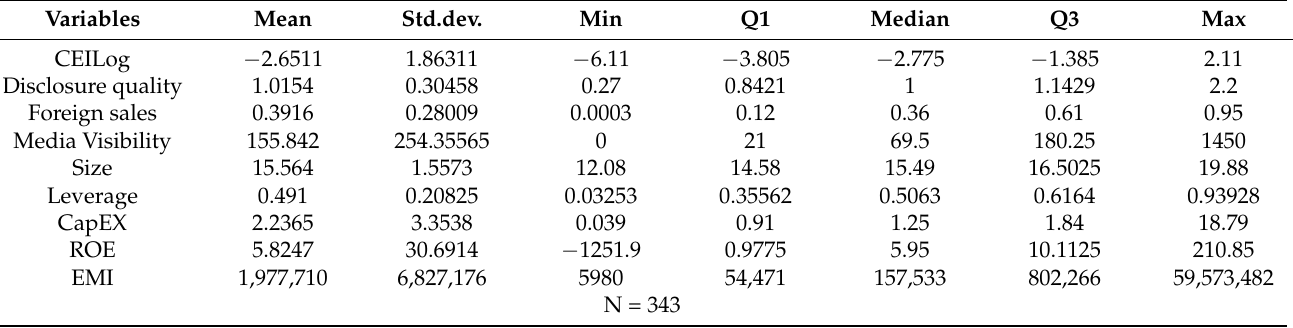
Table 4. Descriptive